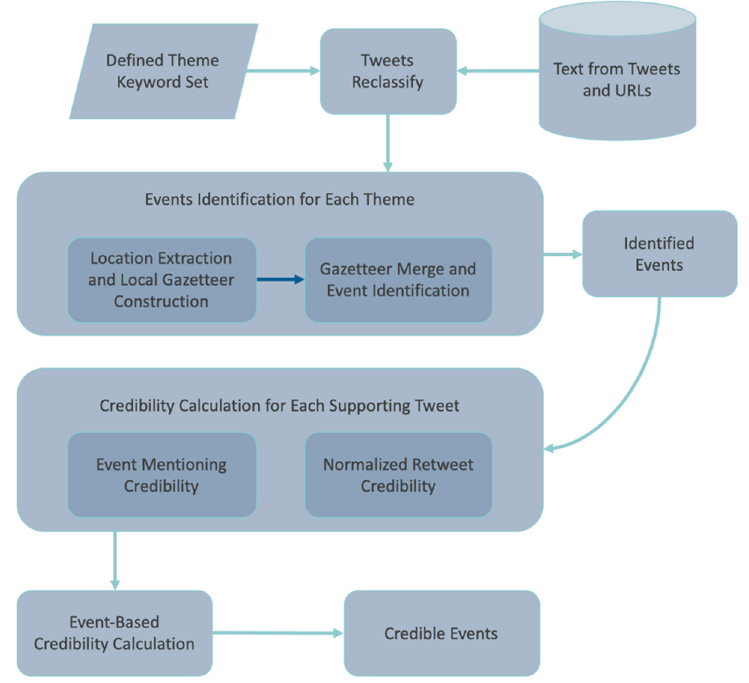
Figure 1. The overall structure of the credibility framework.